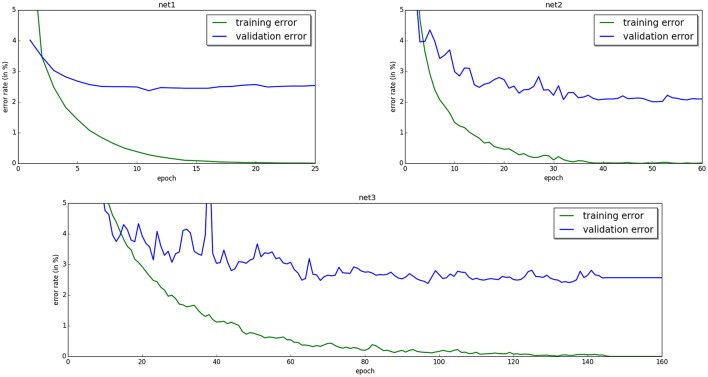
Training and validation error for neural networks with one hidden layer of 500 units (top left), two hidden layers of 500 units (top right), and three hidden layers of 500 units (bottom). The training error eventually decreases to 0.00% in all three cases.